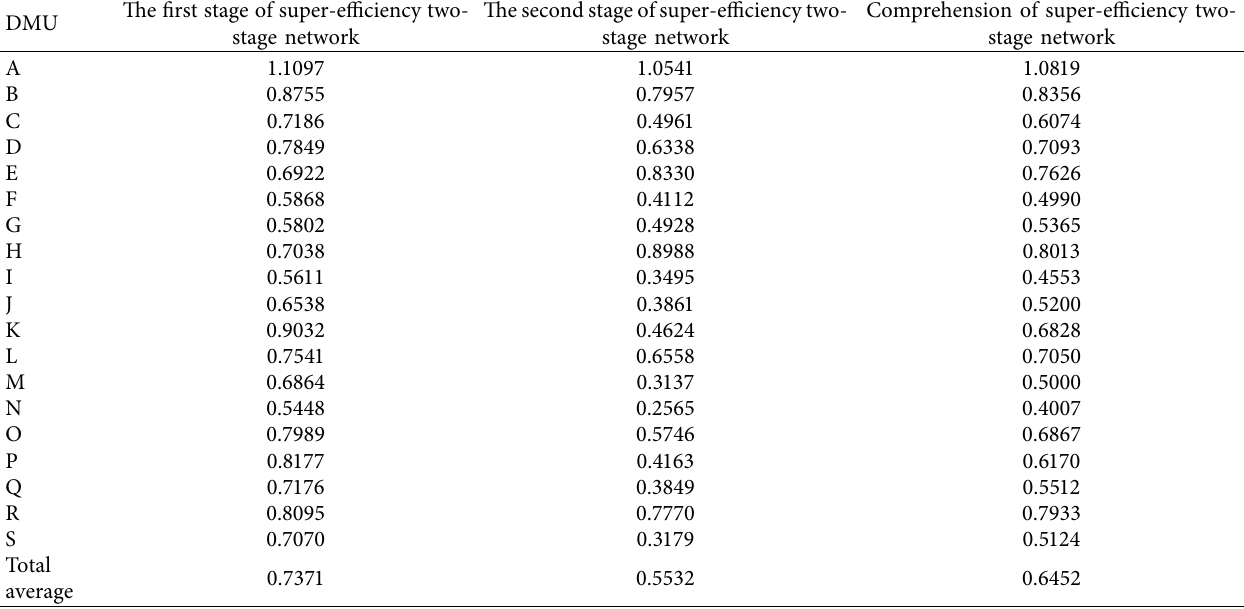
Table 5: Efficiency average of all banks from 2016 to 2020.